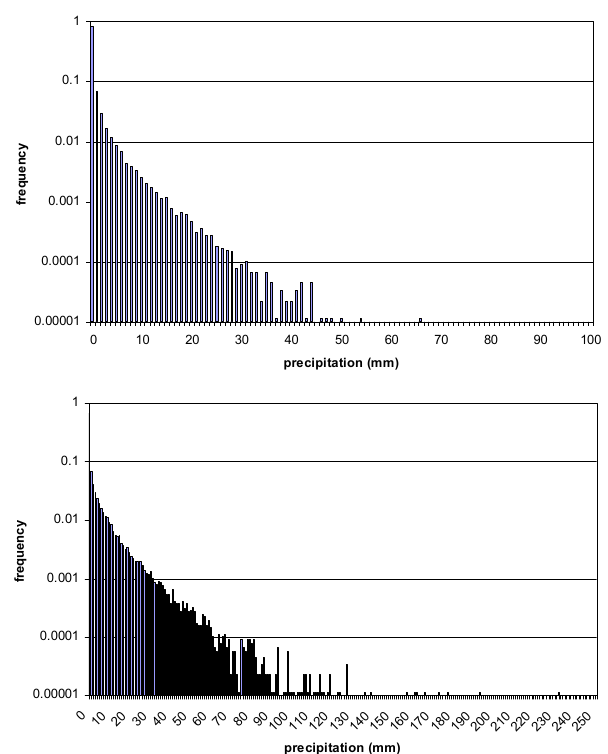
Fig. 2. Observed precipitation PDF: average values (left panel) and Fig. 2 . Observed precipitation PDF: average values (left panel) and maximum values (right maximum values (right panel).